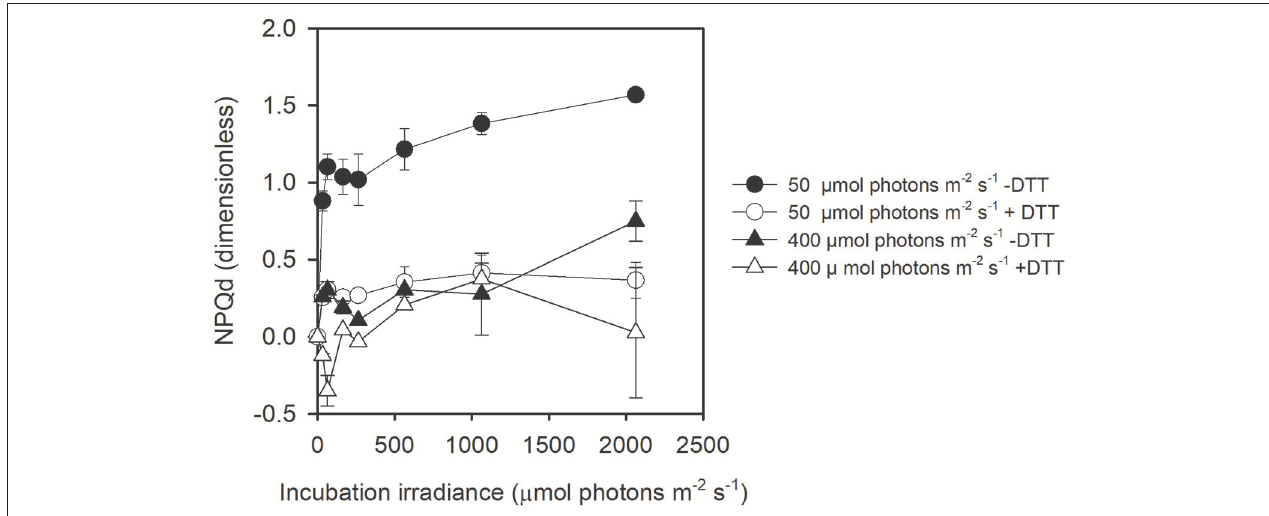
FIGURE 5 | Dynamic NPQ (NPQd) as a function of incubation irradiance in cells acclimated to 50 µ mol photons m − 2 s − 1 and 400 µ mol photons m − 2 s − 1 at 0 ◦ C with and without DTT. Note that NPQd is not available at 5 ◦ C. Each data point is the mean of three independent cultures; error bars represent standard